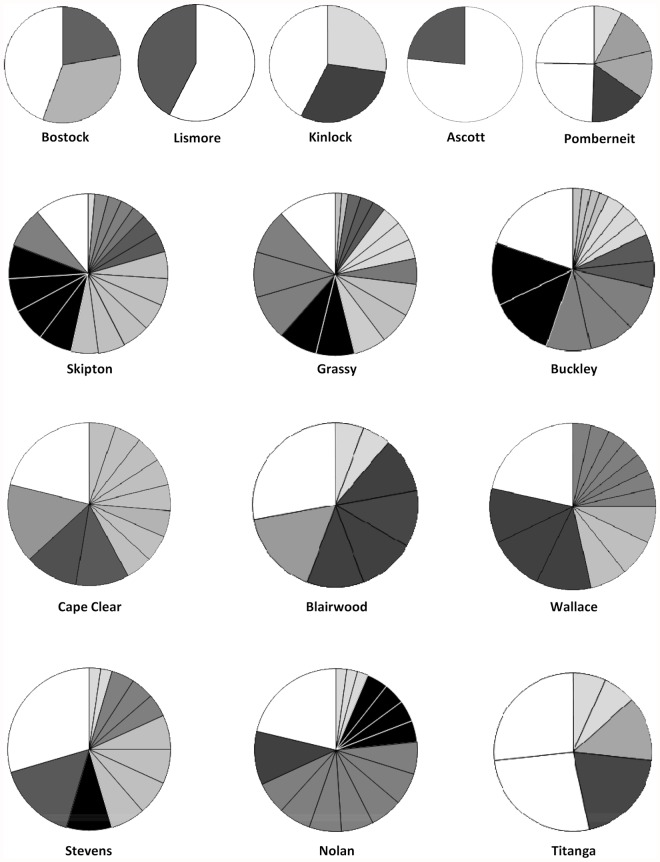
Relative proportion of male tree contribution to the assigned portion of seed crop from each Allocasuarina verticillata population.Pie slices with the same colour indicate the same percentage contribution from several male trees. Pie charts ordered in rows top to bottom as small, linear, patch and restored populations.